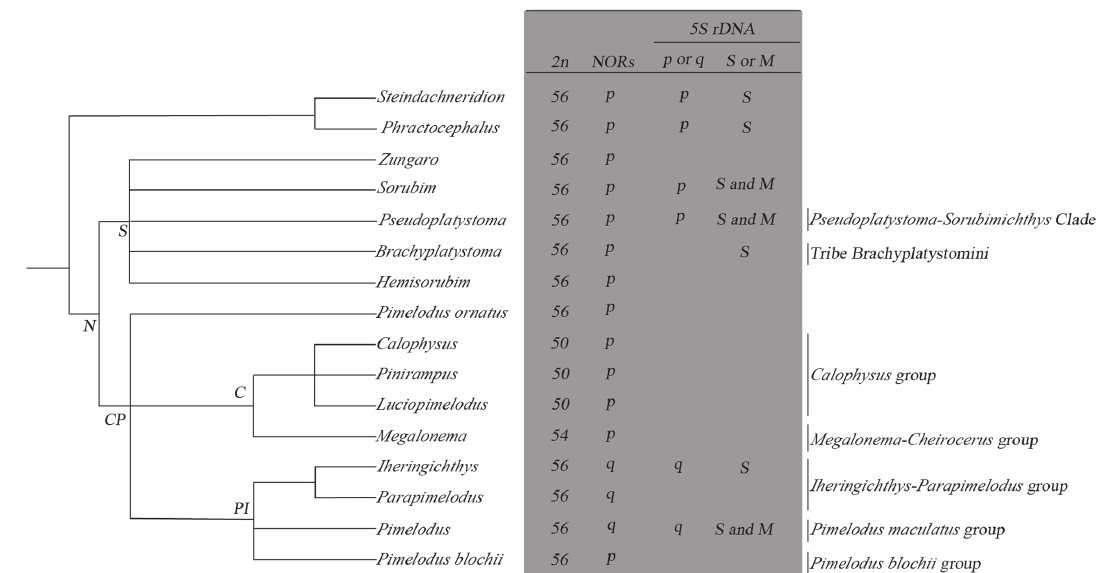
Fig. 5. Cytogenetics data and phylogenetic relationships between Pimelodidae (modified from Lundberg et al ., 2011). N= Neopimelodines; S= Sorubimines; CP= Calophysus - Pimelodus Clade; C = Calophysines; PI = Pimelodus Group; 2n = number diploid; p = short arm; q = long arm; S = simple; M = multiple.